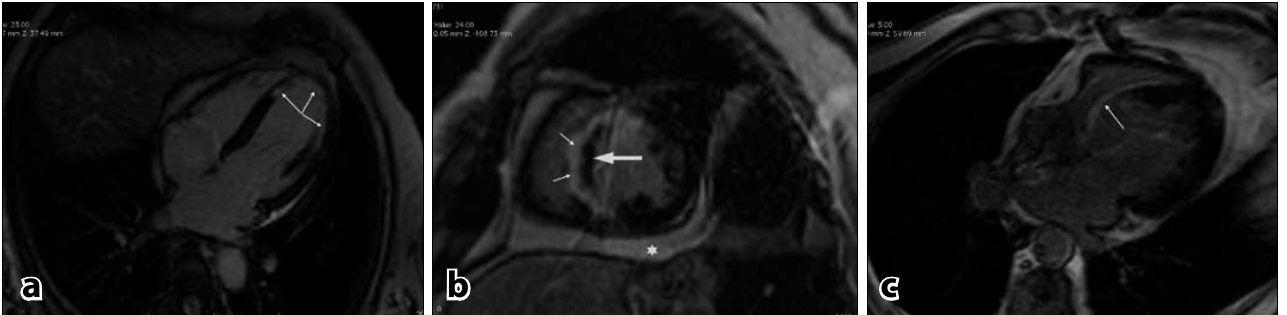
Fig. 7. Delayed enhancement images showing examples of infarction. (7a.) Subendocardial anteroseptal and apical LV infarction (arrows) on four-chamber orientation. (7b.) Acute transmural septal infarct (arrows) in short-axis orientation. The low signal intensity, subendocardial region within the infarct (block arrow) indicates ‘no reflow’ infarction (microvascular obstruction) associated with a poorer prognosis and increased chance of myocardial rupture in the acute setting and aneurysm formation in the chronic setting. Note the simple pericardial effusion (star). (7c.) Septal transmural infarct with aneurysm formation (arrow) on four-chamber orientation.